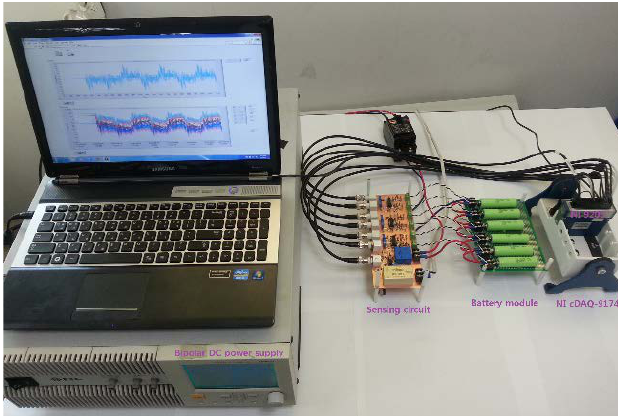
Figure 5. Experimental setup for the battery module test.